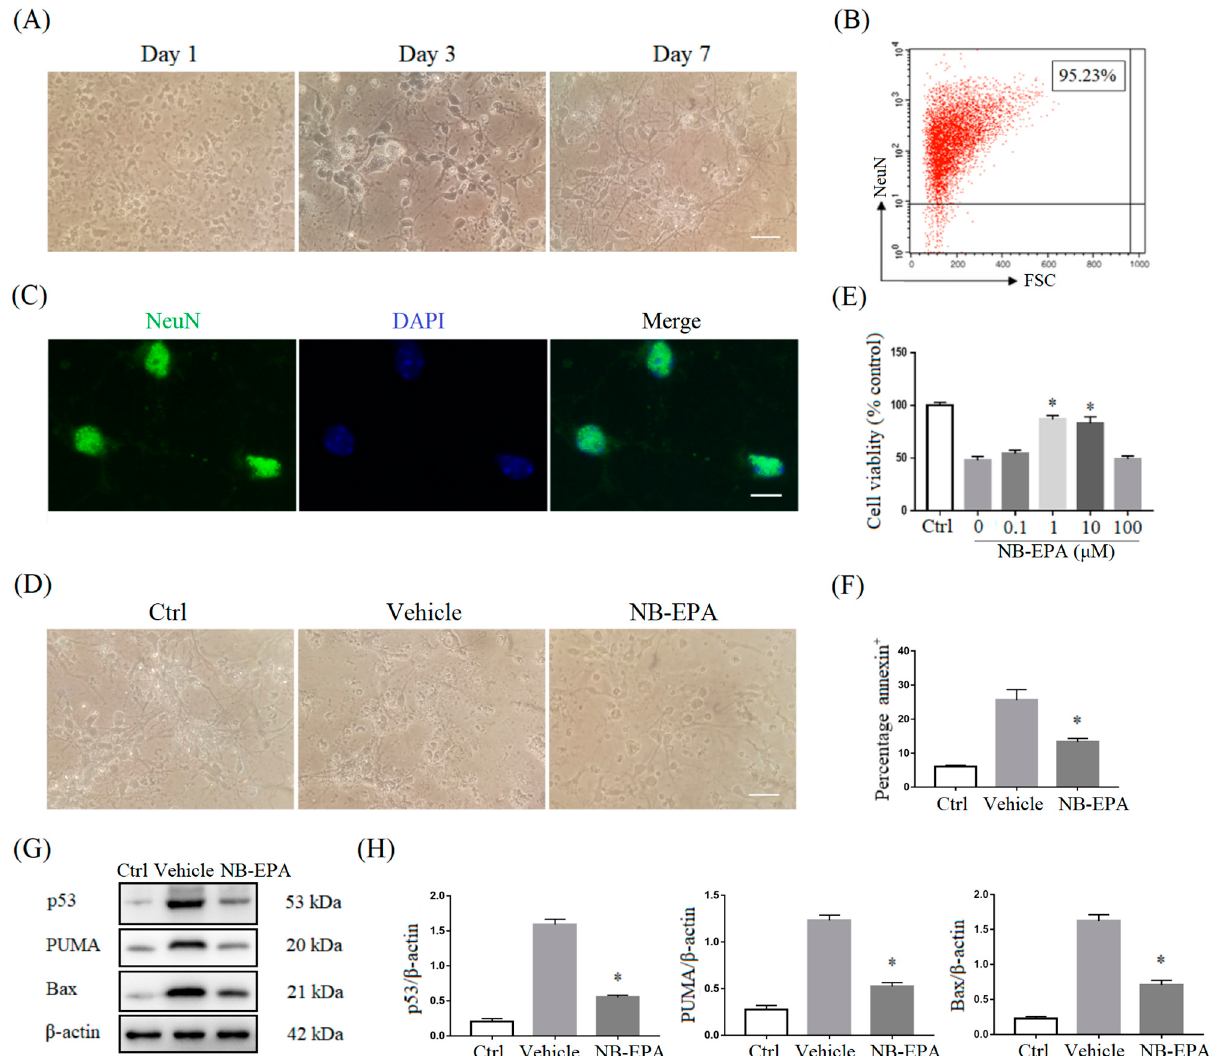
Figure 5. NB-EPA reduces ischemic neuronal injury after OGD challenge. ( A ) Representative images of primary cortical neurons cultured at 1, 3 and 7 days (Scale bar, 25 μ m). ( B ) The percentage of NeuN + cells from primary cortical neurons cultured for 7 days in vitro. ( C ) Representative images of NeuN (green) and 4 ′ ,6-diamidino-2-phenylindole (DAPI) (blue) from primary cortical neurons cultured for 7 days in vitro (Scale bar, 10 μ m). ( D ) Representative images of primary cortical neurons from every group at 24 h of culture after 3 h OGD (Scale bar, 25 μ m). ( E ) CCK-8 assay in neuron-enriched cultures subjected to 3 h OGD or control conditions followed by treatment with a range of concentrations of NB-EPA for another 24 h. ( F ) The percentage of annexin + neurons at 24 h of culture after 3 h OGD. ( G ) Representative Western blot images of p53, PUMA, and Bax from every group at 24 h of culture after 3 h OGD. ( H ) Densitometric analysis of data is shown in ( G ). Data are mean ± SEM ( n = 3 in each group). * p < 0.05 compared to